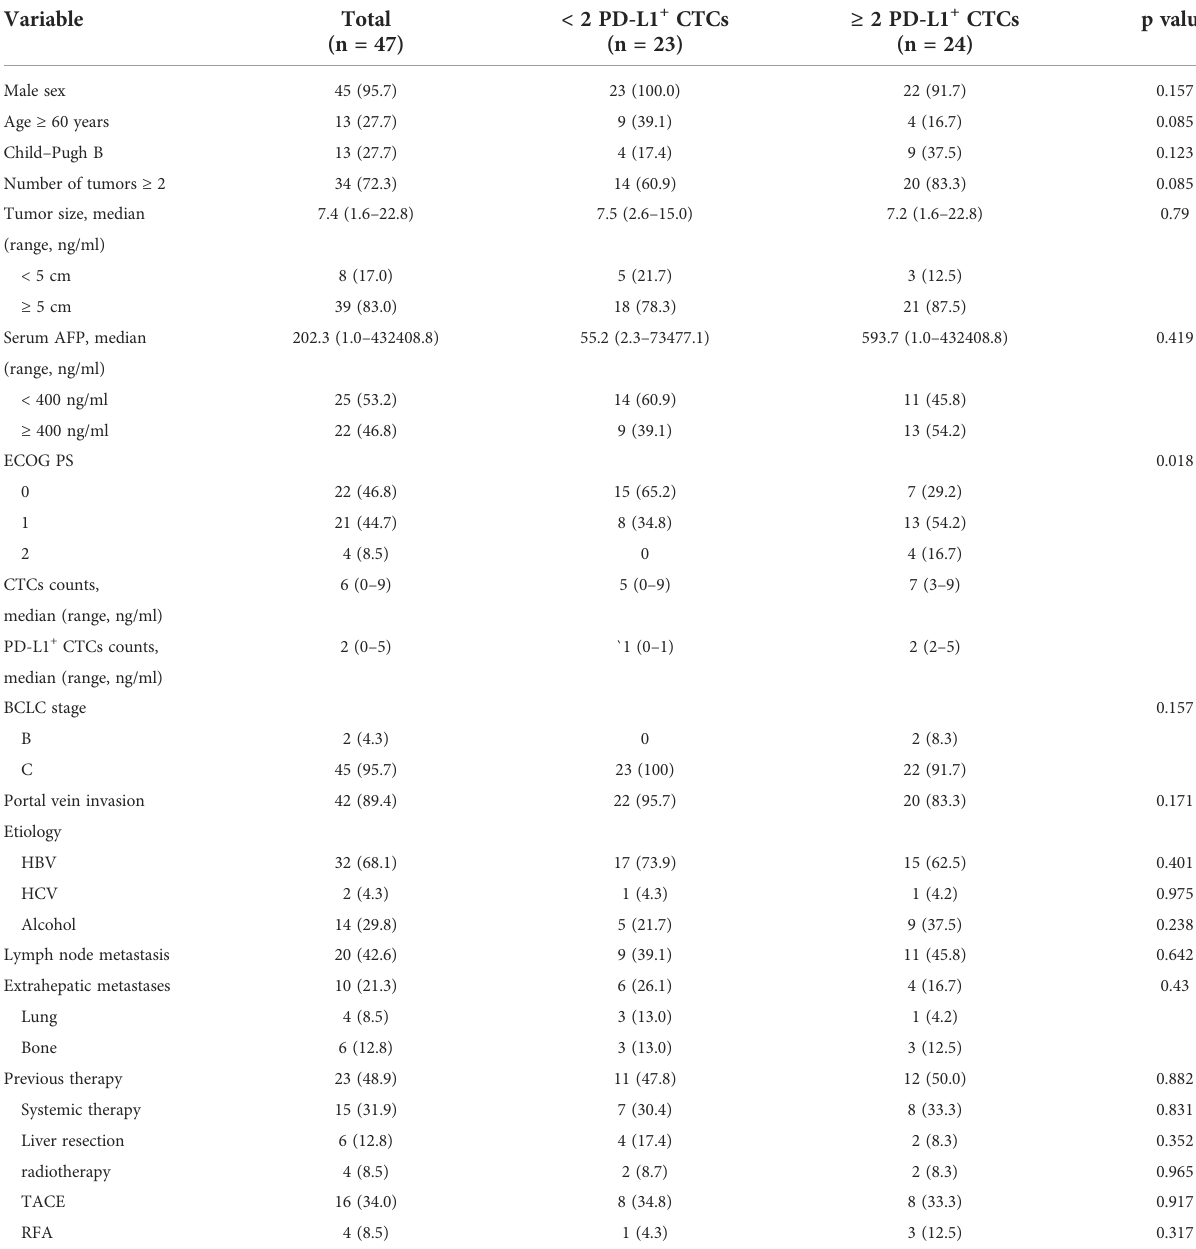
TABLE 1 Baseline